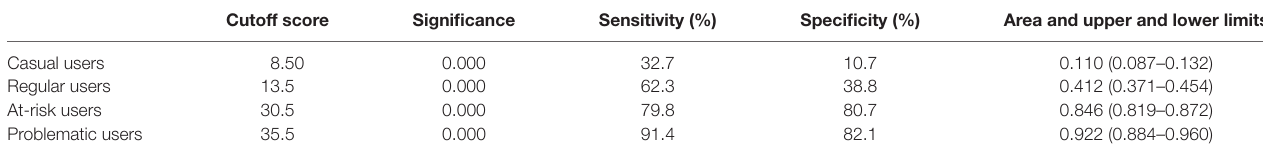
Table 5 | receiver operating characteristic (rOc) curve and cutoff scores of the Mobile Phone addiction craving scale for each category of user.